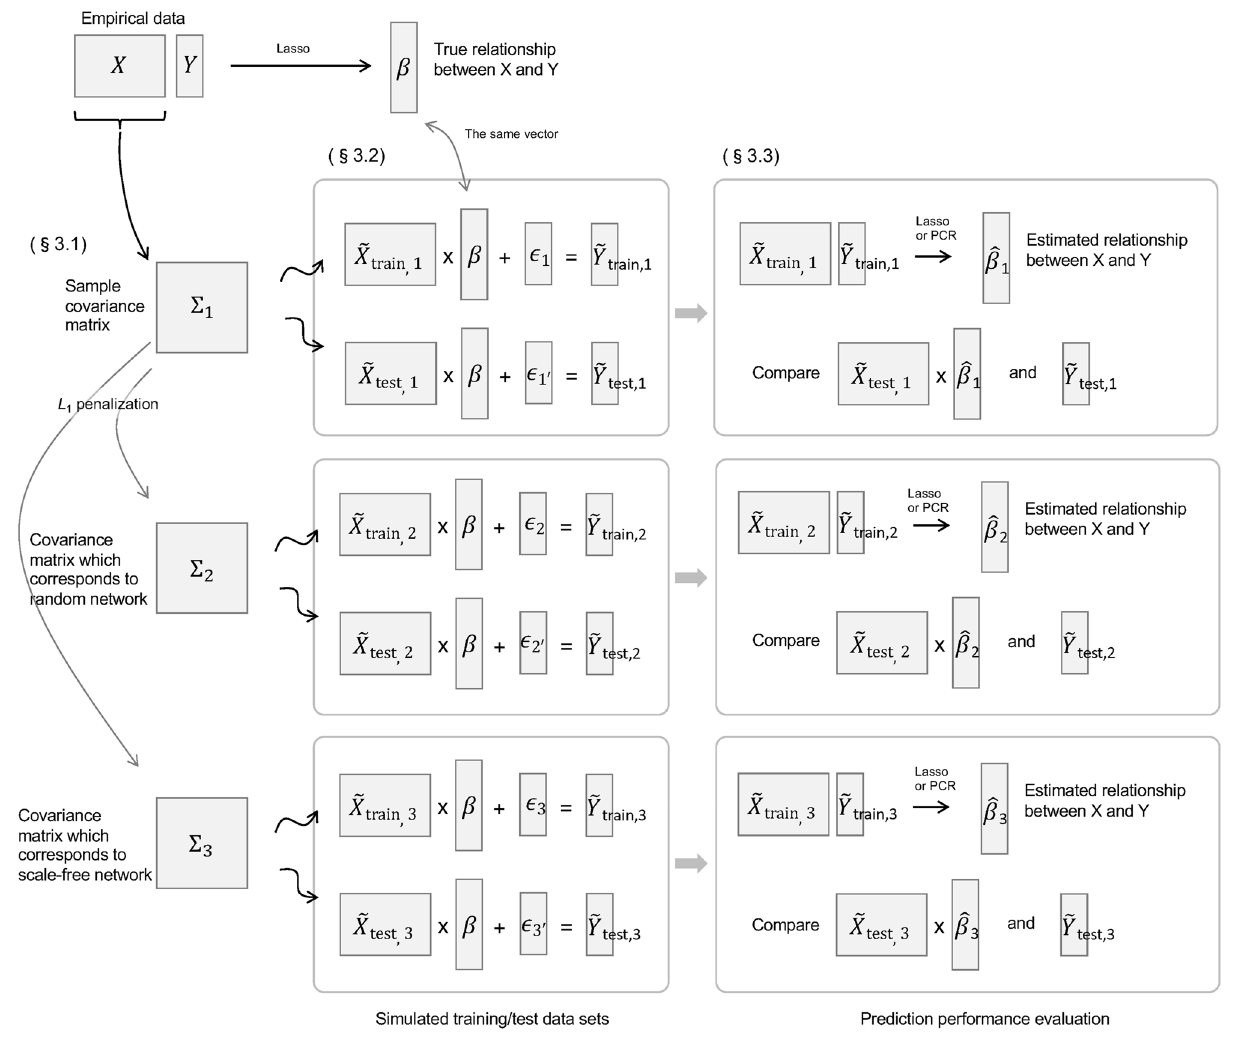
Figure 1. Overview of the